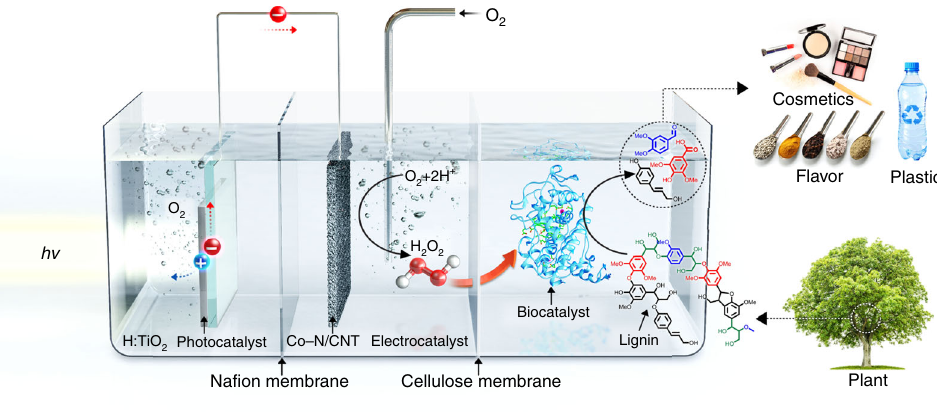
Fig. 1 Schematic illustration of the three-compartment photo-electro-biochemical reactor. The photo-electro-biochemical reactor consists of three separate compartments. The fi rst compartment (left-hand side) is the anodic part of the photo-electrochemical cell where water oxidation takes place. The cell comprises a cubic reactor with a quartz window on the left-hand side for the photochemical reactions on the TiO 2 photoanode surface. Rutile TiO 2 nanowire fi lms grown on fl uorine-doped tin oxide (FTO) glass substrate are used as the photoanode. Hydrogen treatment was performed to enhance the photocatalytic activity of TiO 2 photoanode (H:TiO 2 ). The photoanode is connected to the Co – N/carbon nanotube (CNT) cathode through a copper wire for in situ H 2 O 2 generation in the second compartment (middle part). A Na fi on proton exchange membrane separates the anodic and cathodic parts of the photo-electrochemical cell. The use of a Na fi on membrane also helps to prevent the oxidation of photogenerated H 2 O 2 on the highly photoactive H:TiO 2 photoanode surface. To carry out the continuous O 2 reduction to H 2 O 2 on the Co – N/CNT cathode surface, the second compartment is also equipped with continuous O 2 gas supply. However, the presence of (cid:129) O 2 − radicals, a high H 2 O 2 concentration, and continuous O 2 bubbling have adverse effects on the biocatalytic activity of enzymes. Therefore, the photo-electrochemical and biochemical cells are separated by a cellulose membrane. The schematic of the second and third compartments shows the gradual increase in the concentration of photogenerated H 2 O 2 and continuous fl ow to the biocatalytic system (third compartment), which are ideal conditions for selective lignin